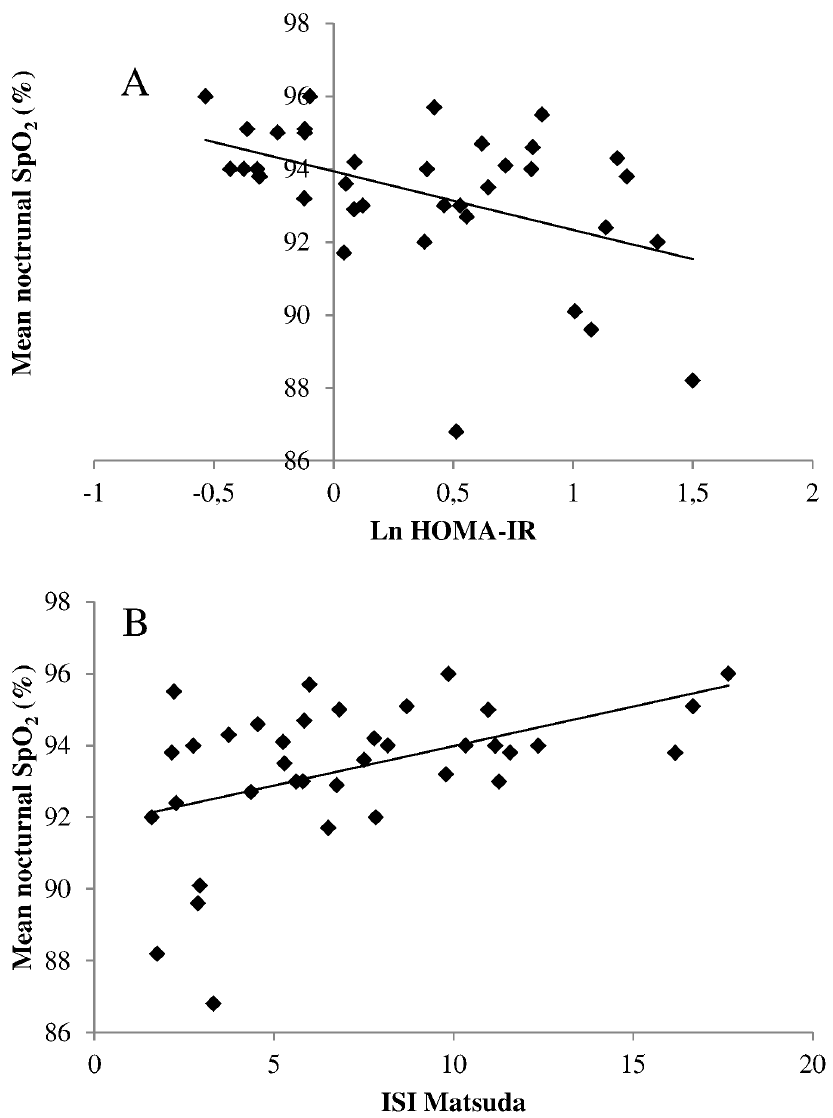
Figure 2. Univariate linear correlation between nocturnal hypoxia and insulin resistance. The average degree of oxyhemoglobin desaturation during the night (mean nocturnal SpO 2 ) was negatively correlated to the degree of insulin resistance (A) as estimated by HOMA-IR (r= 2 0.46, p=0.004) and positively correlated to the degree of insulin sensitivity (B) as estimated by the insulin sensitivity index of Matsuda (ISI Matsuda, r=0.46,